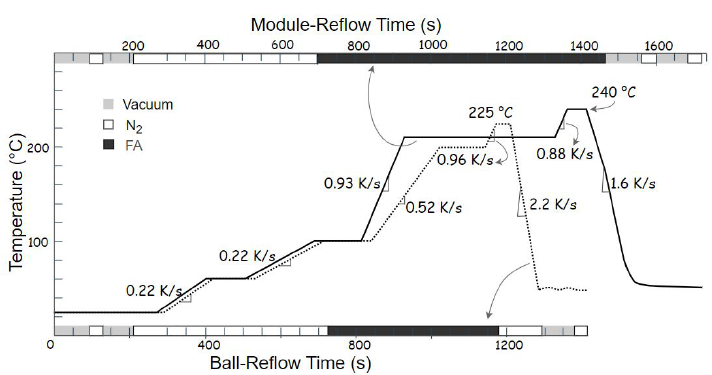
Figure 5. Temperature profile for the ball reflow (dotted curve) and module reflow (solid